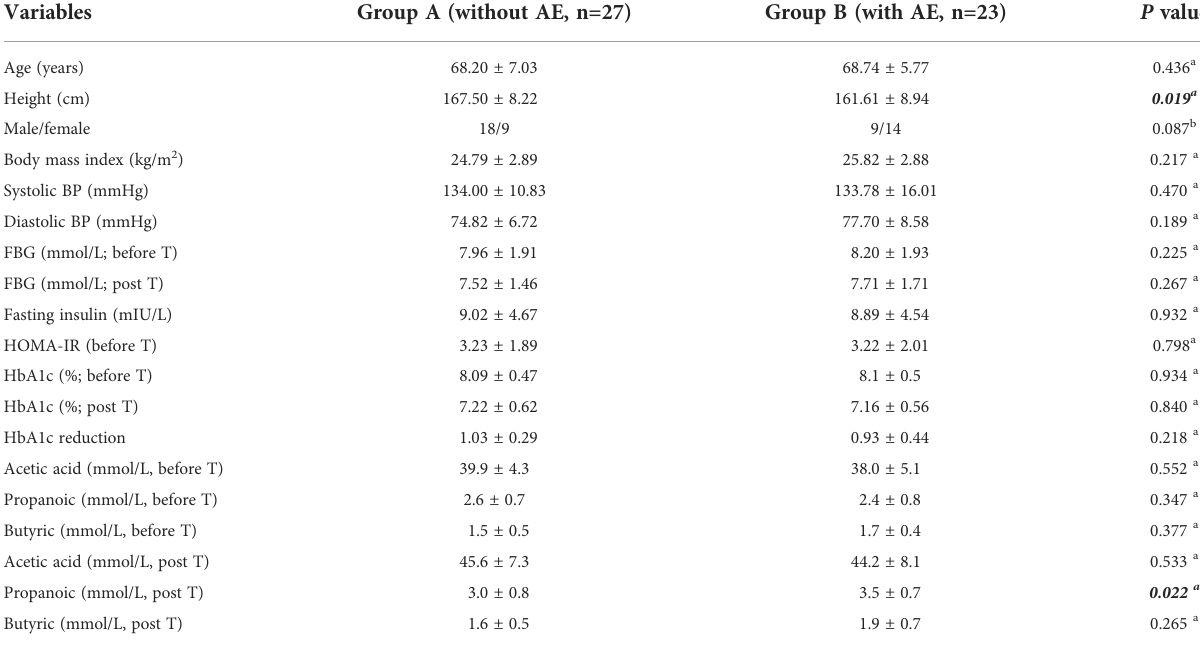
TABLE 1 Characteristics of patients with type 2